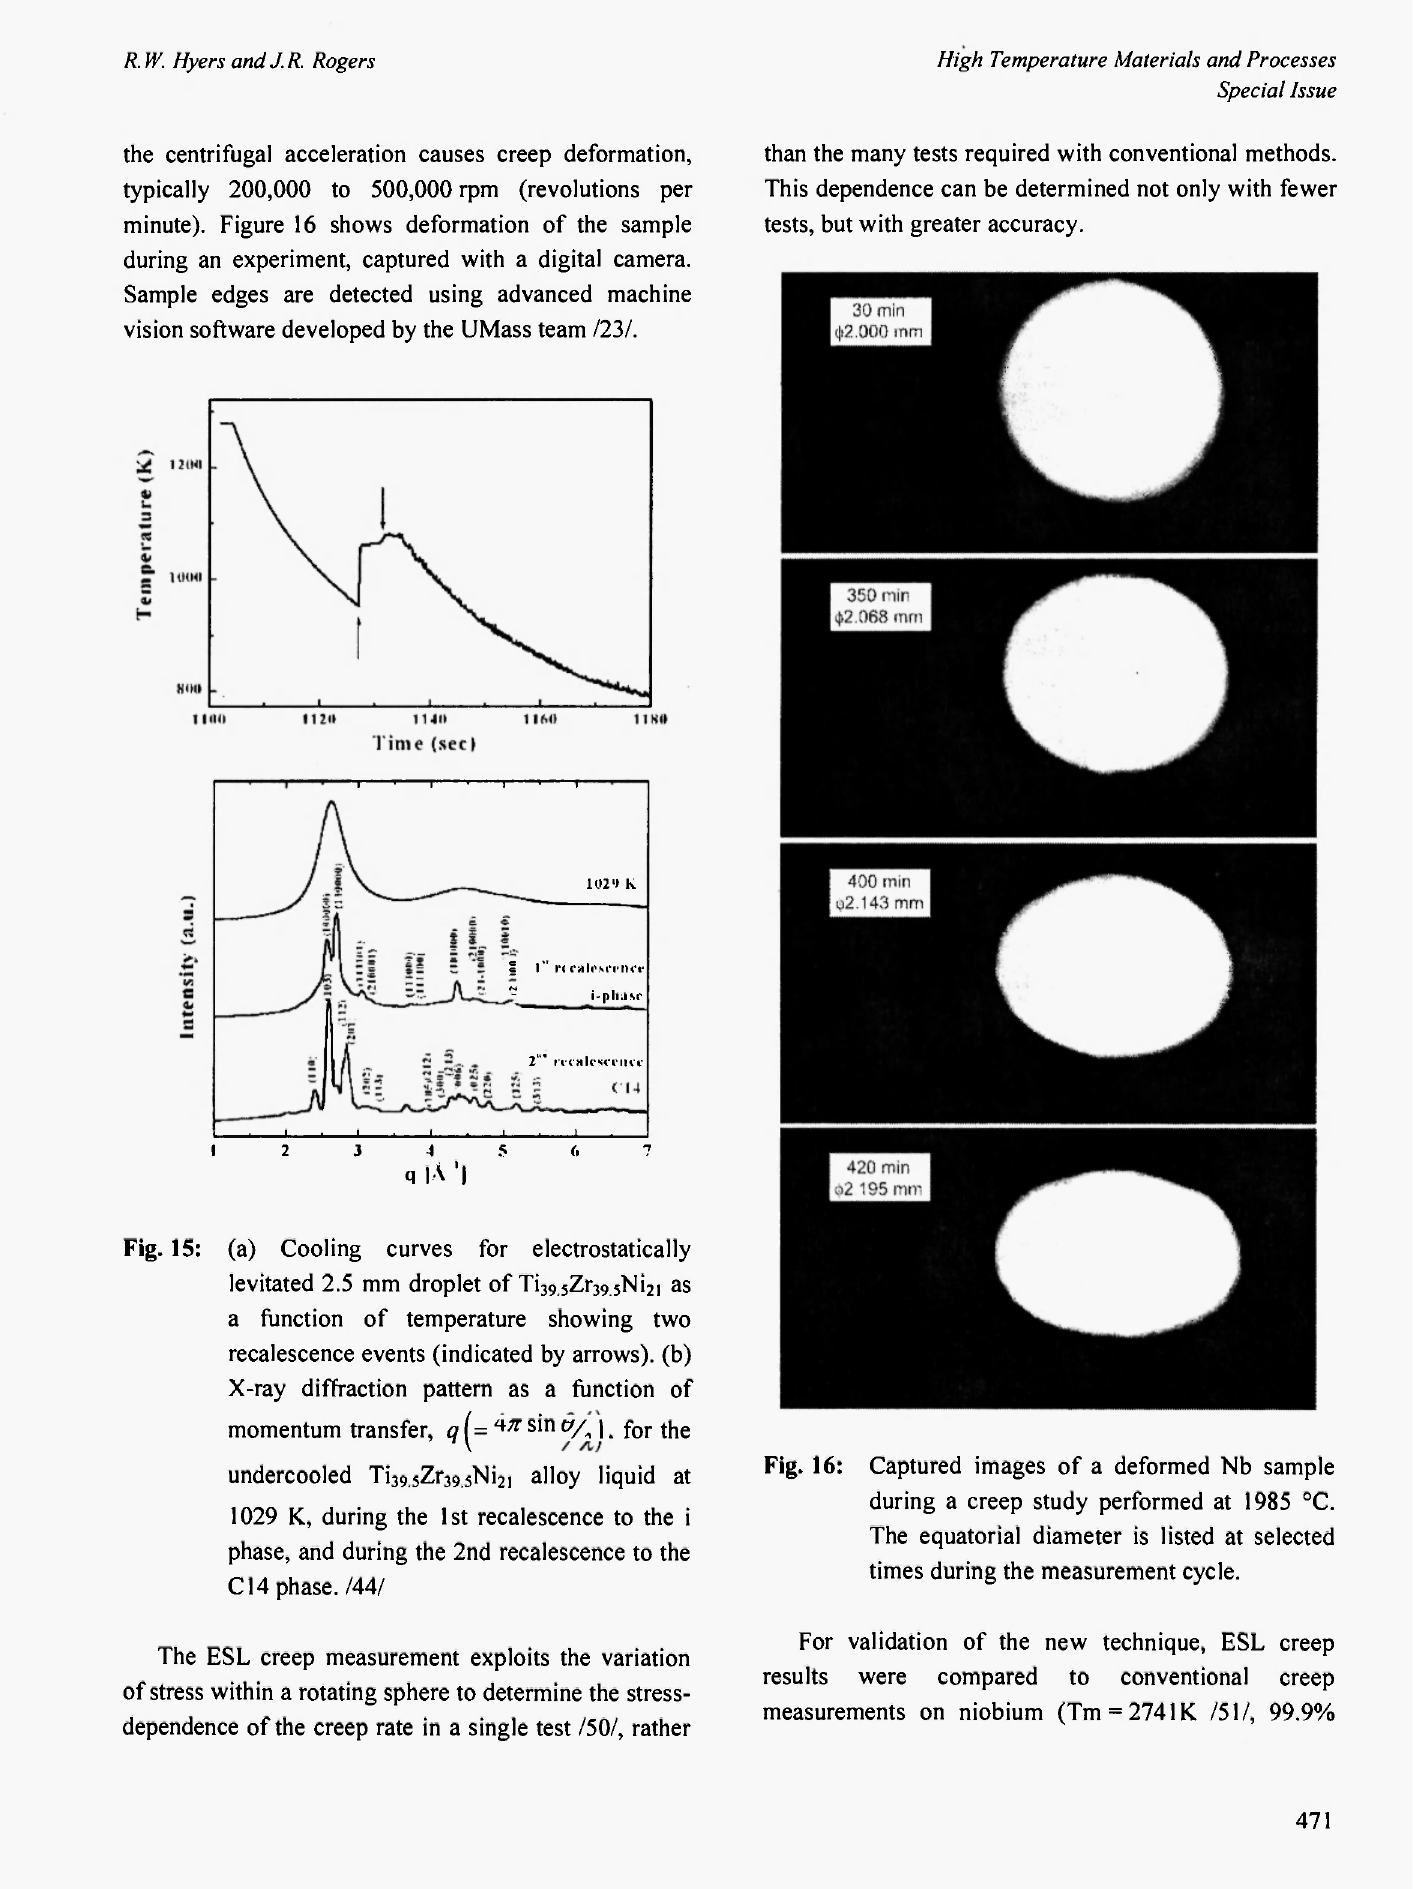
Fig. 16: Captured images of a deformed Nb sample during a creep study performed at 1985 °C. The equatorial diameter is listed at selected times during the measurement cycle. For validation of the new technique, ESL creep results were compared conventional creep measurements on niobium (Tm = 2741K /51/,